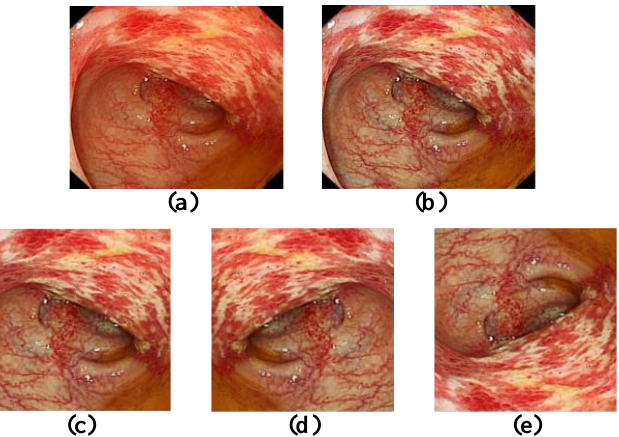
Figure 5. Data enhancement presentation. ( a ) The original image; ( b ) contrast-limited adaptive histogram equalization (Clahe); ( c ) image clipping; ( d ) horizontal flipping; ( e ) vertical